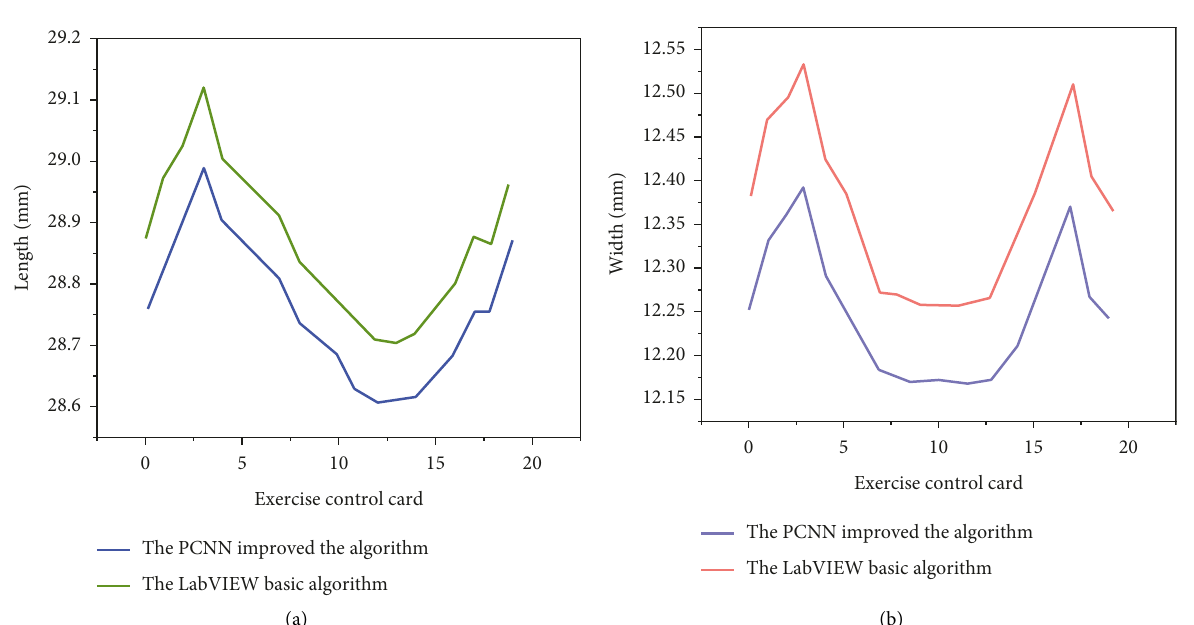
Figure 4: Test results of any part in the same position and direction under the same light. (a) Part length measurement results. (b) Part width measurement